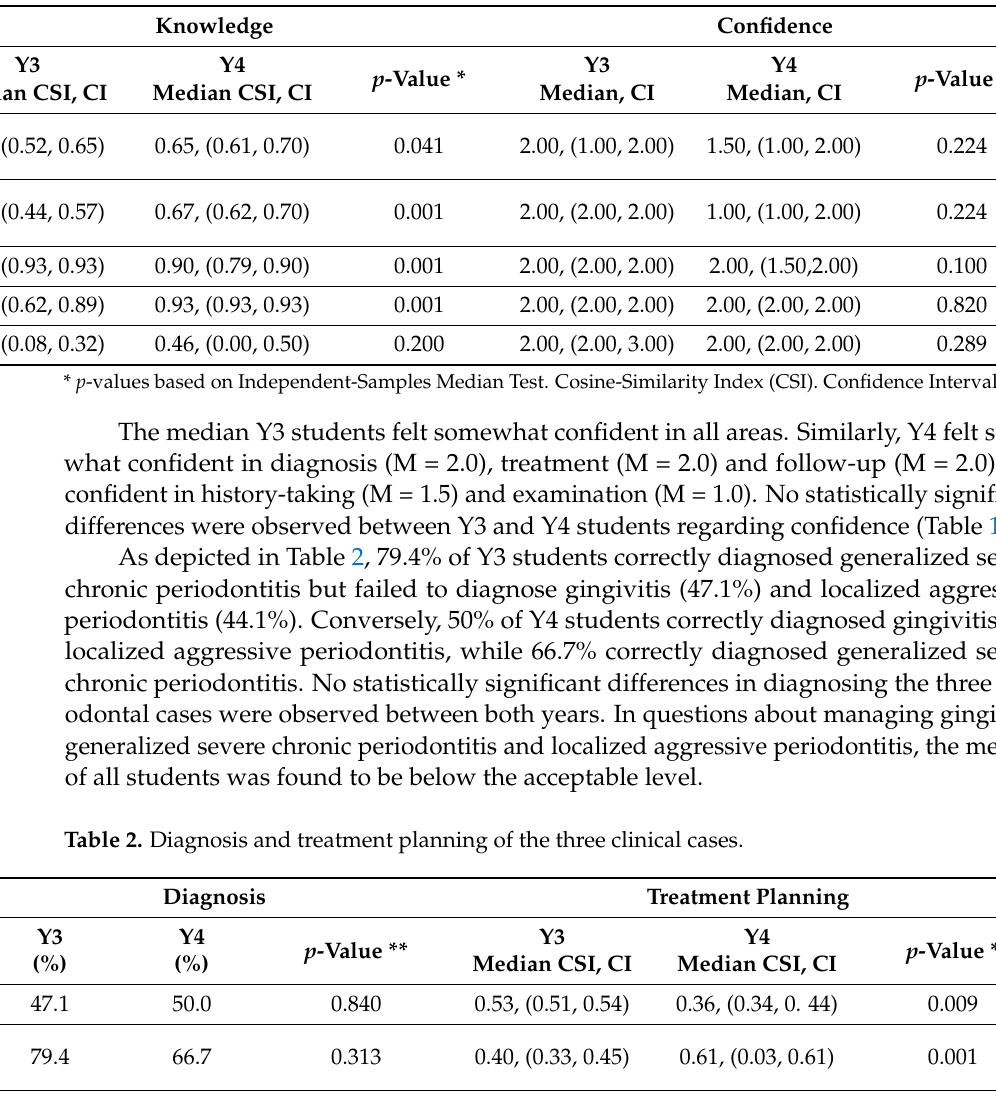
Table 1. Knowledge and confidence in the five periodontal areas.